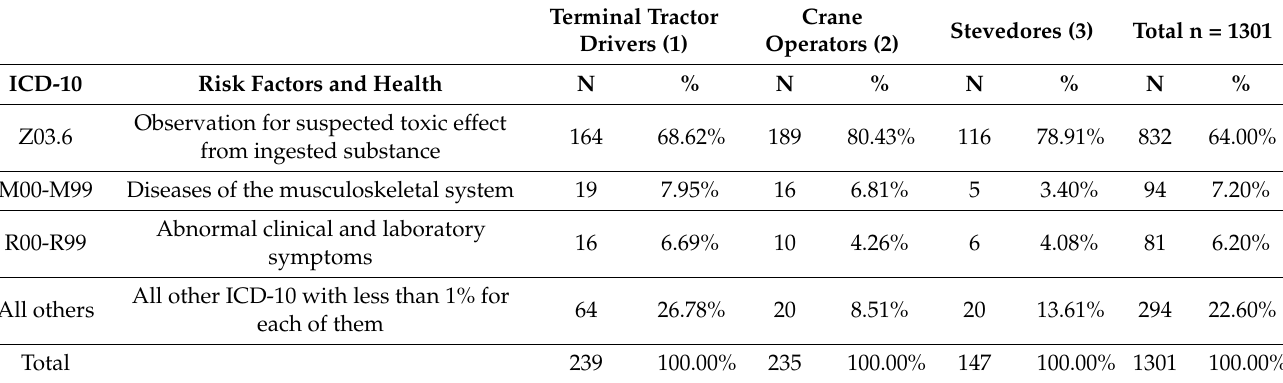
Table 3. ICD-10 distribution of the main patient job groups and main ICD-10 codes (n = 1301).